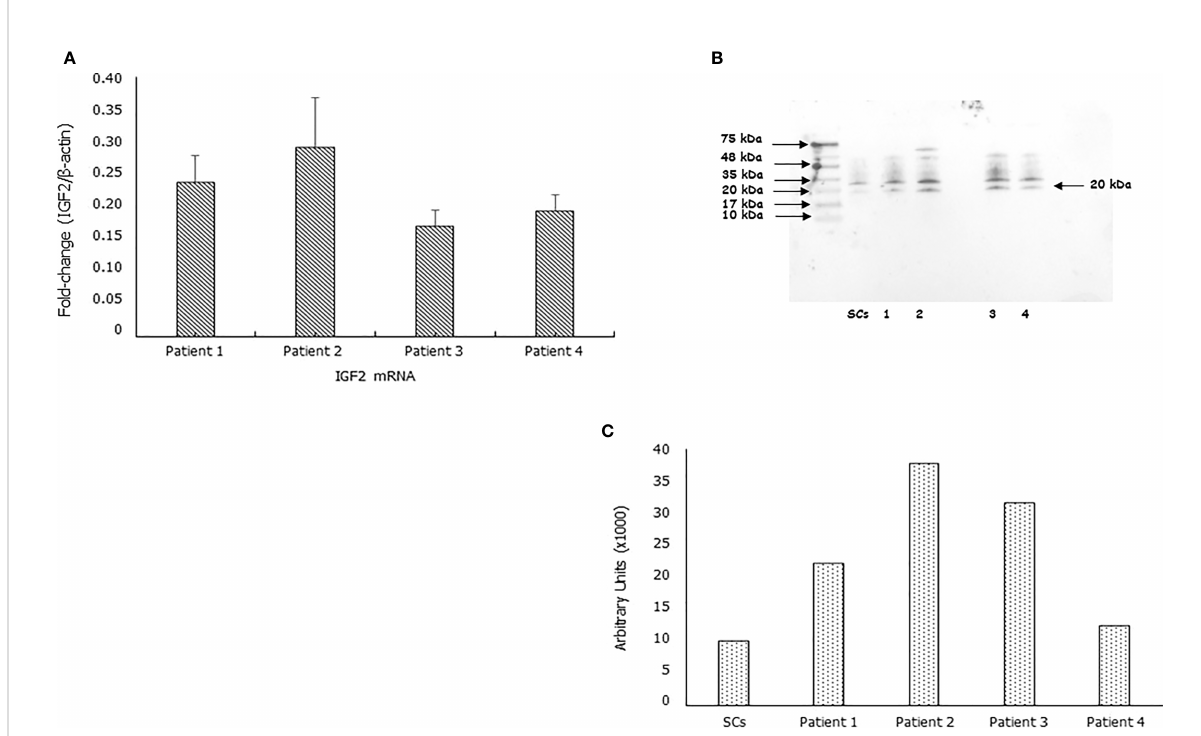
FIGURE 1 IGF2 mRNA and protein are expressed in human spermatozoa. RT-PCR analysis (A) , immunoblots (B) , and densitometric analysis (C) of IGF2 in human spermatozoa. MA5-17096, clone 8H1, detects IGF2 which has a predicted molecular weight of approximately 20.1 kDa. The observed molecular weight of the protein may vary from the mentioned predicted molecular weight due to post-translational modi fi cations, post translation cleavages, relative charges, and other experimental factors, as shown by the presence of other bands at the highest molecular weight (in particular at 35 KDa). Data represent the mean ± SD of three independent experiments, each performed in triplicate. Porcine Sertoli cells (SCs) were used as a positive control. Magni fi cation